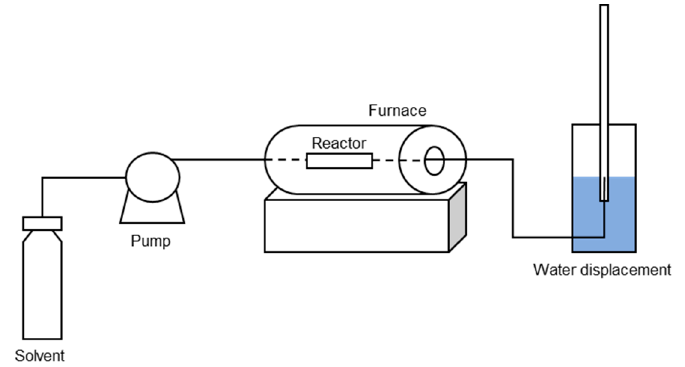
Figure 13. Diagram of continuous flow set up.